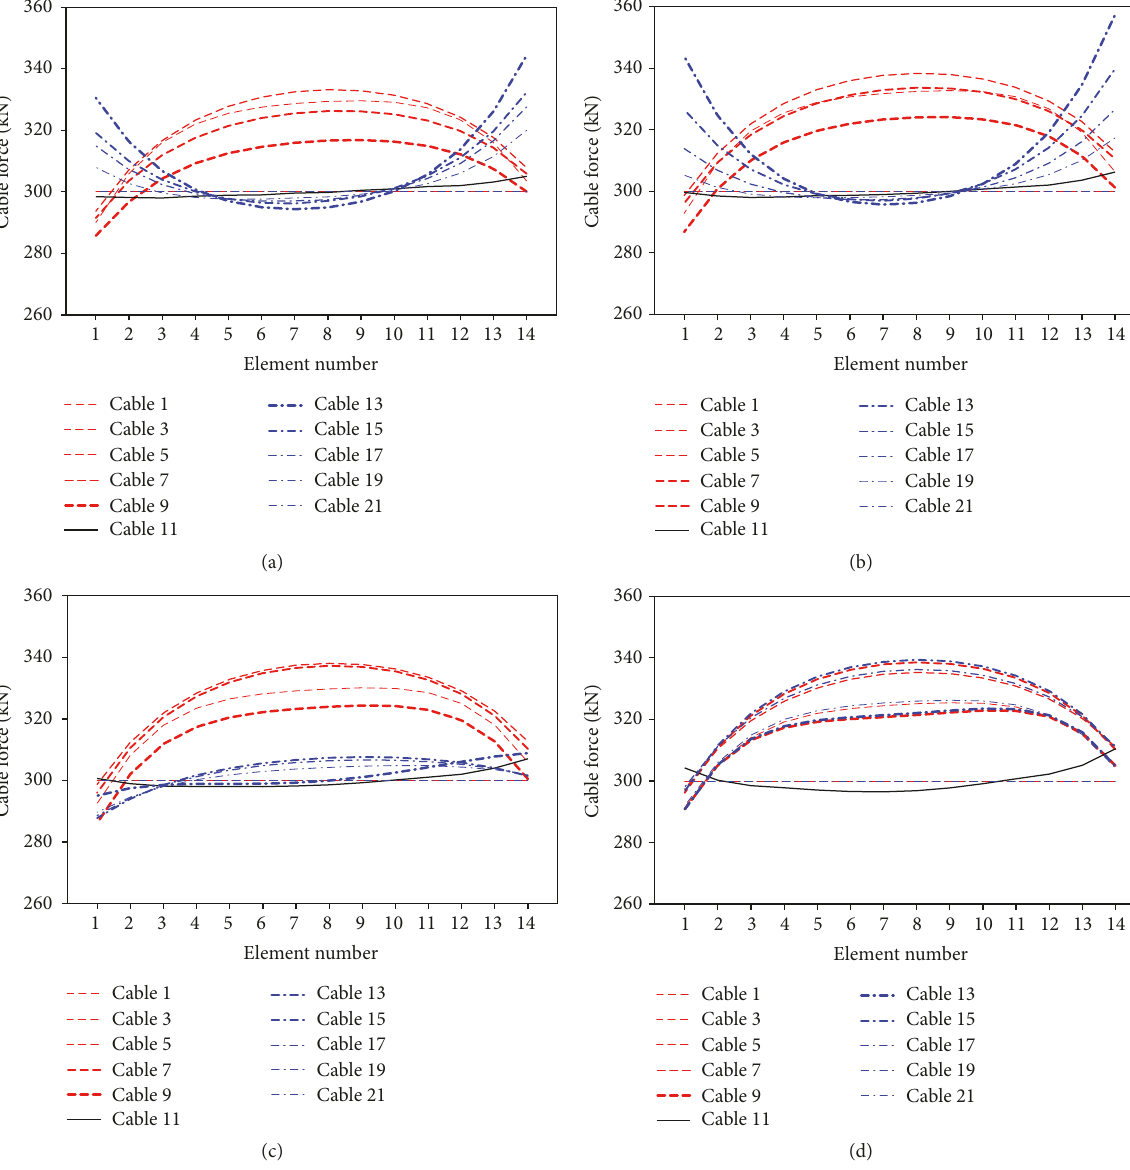
Figure 16: Mean cable force under different wind directions: (a) 0 ∘ , (b) 15 ∘ , (c) 30 ∘ , and (d) 45 ∘